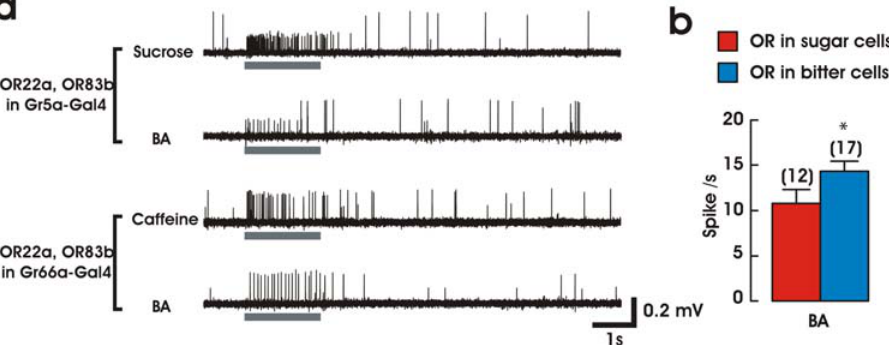
Figure 3. Responses to odors in taste neurons expressing Ors under different Gal4 drivers. a. Taste neurons expressing Or22a + Or83b in sugar-sensing neurons (driven by Gr5a -Gal4) respond to sugar and to butyl acetate (first two traces: smaller amplitude spikes); taste neurons expressing Or22a + Or83b in bitter-sensing neurons (driven by Gr66a -Gal4) respond to caffeine and to butyl acetate (lower two traces: larger amplitude spikes). Gray bar=2 s stimulus. Horizontal black bar: 1 s; vertical bar: 0.2 mV. b. Comparison of the responses of altered GRNs to butyl acetate depending on the driver, Gr5a -Gal4 (‘‘sugar cells’’) or Gr66a -Gal4 (‘‘bitter cells’’) (mean 6 S.E.M.; n=12, 17 trials). There is a small difference in response intensity to butyl acetate in Gr5a - and Gr66a -GRNs (*: P=0.039, Student’s t-test).